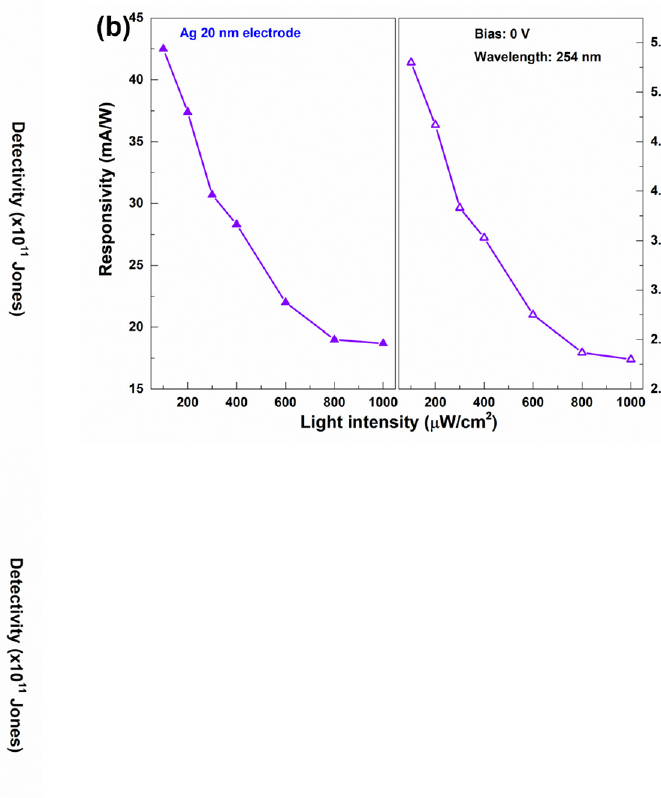
Figure 11. Photocurrent density change of device according to light intensity. ( a ) Ag:AZO 20 nm; ( b ) Ag 20 nm; ( c ) AZO 20 nm.